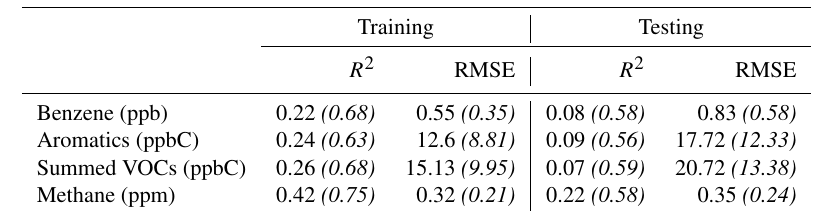
Table 7. Model 1 regression statistics, excluding MOx sensor data (original results, where the MOx sensor was included, are in parentheses for comparison).